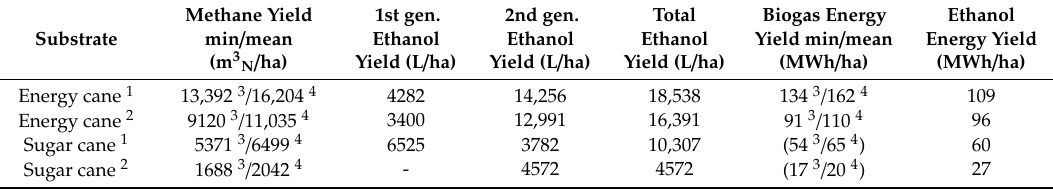
Table 5. Theoretical energy cane-based methane yield, first- and second-generation ethanol yields, area-related energy yields from biogas, and total ethanol